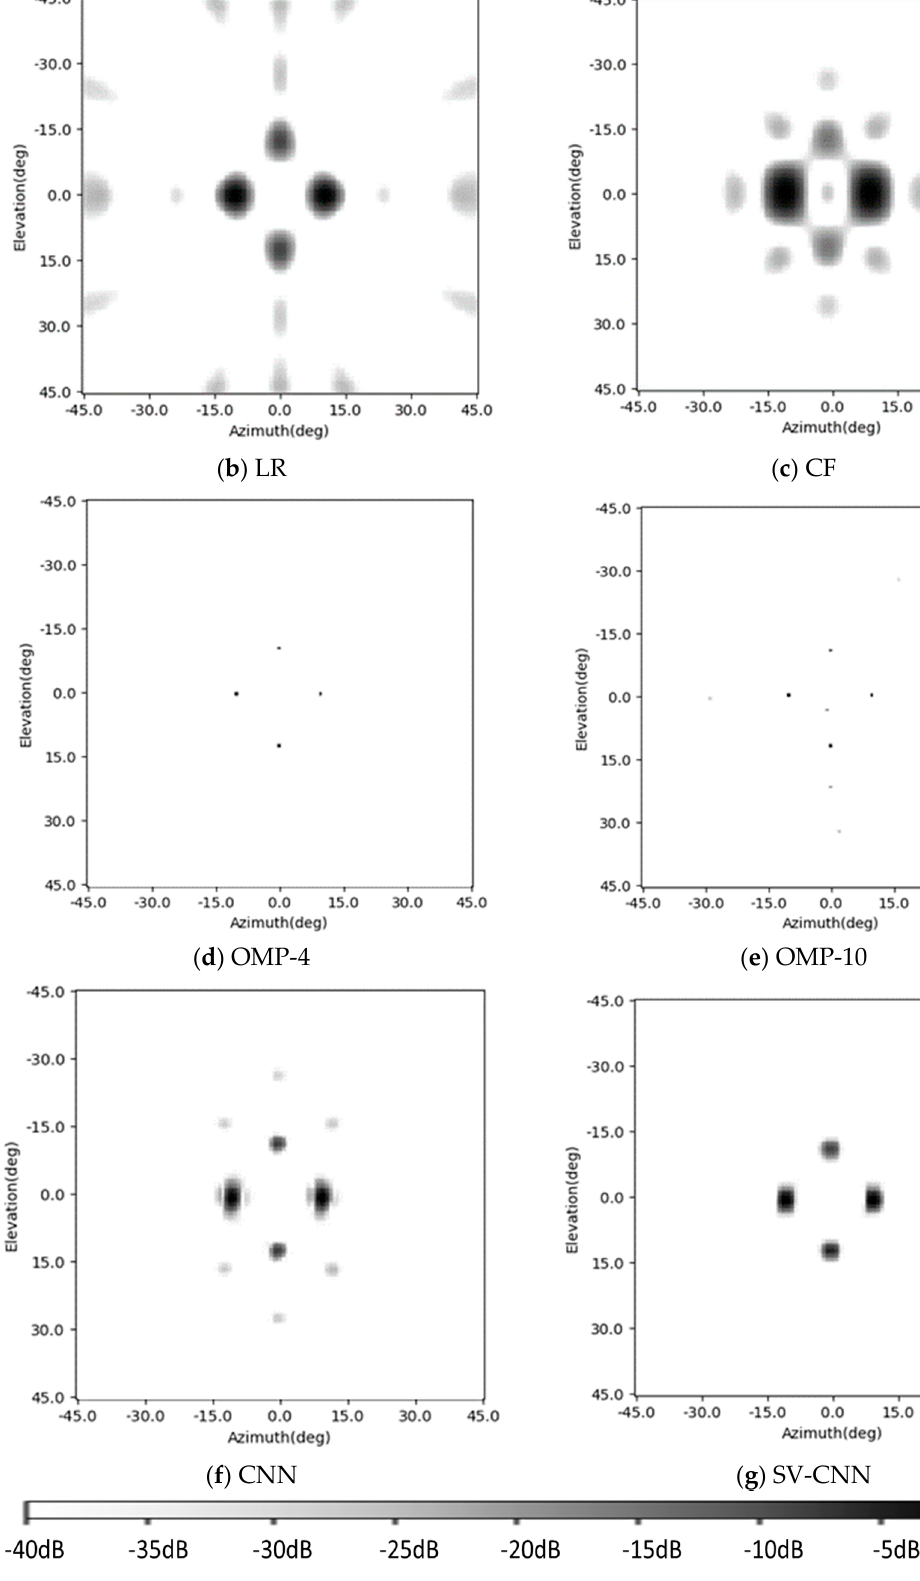
Figure 14. Enhancing results of different methods; ( a ) the original image; ( b ) the enhancing result of the Lucy–Richardson algorithm; ( c ) the result of the CF algorithm; ( d ) the enhancing result of the OMP with the sparsity of 4; ( e ) the enhancing result of the OMP with the sparsity of 10; ( f ) the enhancing result of the CNN; ( g ) the enhancing result of the SV-CNN.